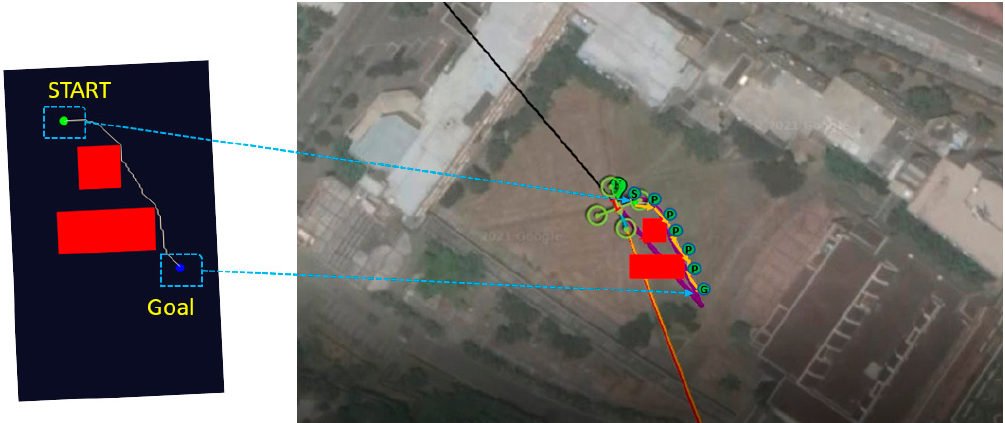
Figure 32. The Q-learning path on the map in Experiment 2.